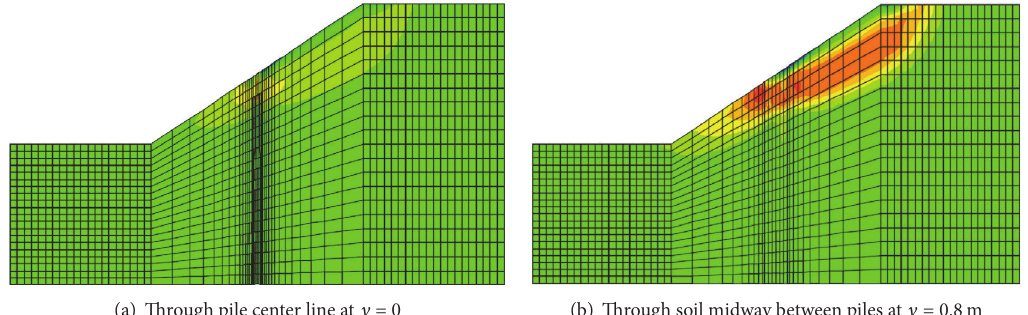
Figure 15: Failure mode of a slope with piles C = 0.35 at different sections.